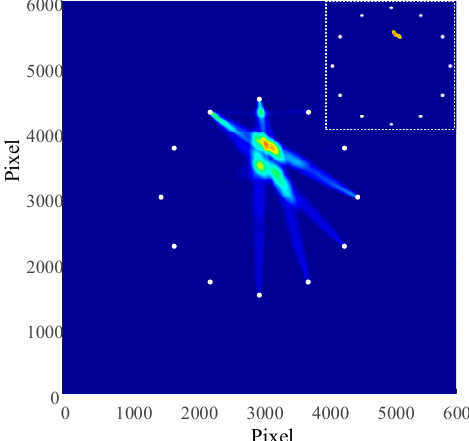
Figure 10. Damage imaging results.